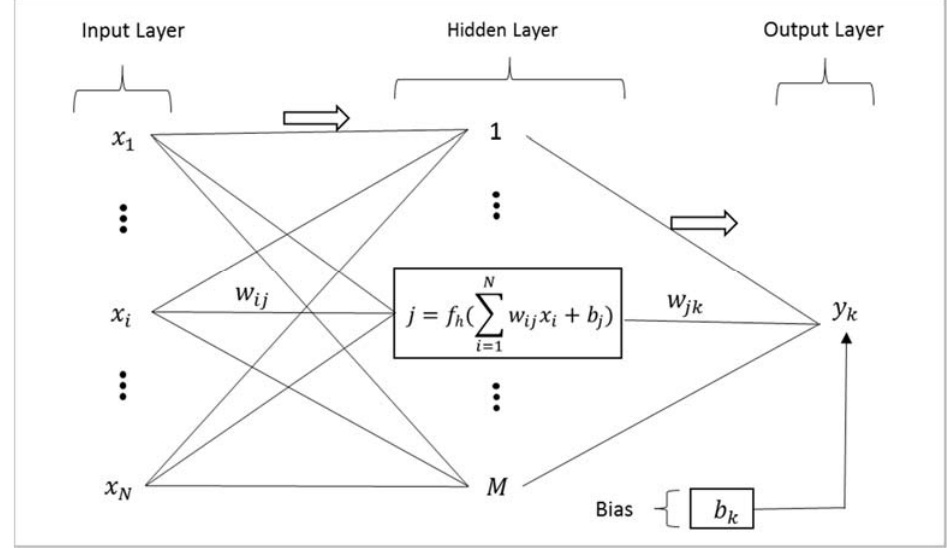
Figure 2. A three ‐ layered feed ‐ forward neural network. Figure 2. A three-layered feed-forward neural